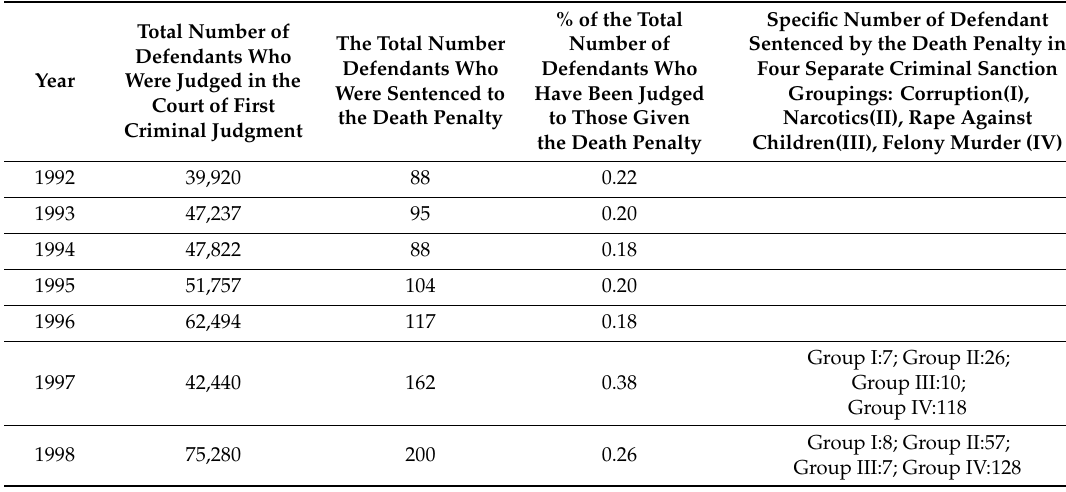
Table 3. Death penalty application in Vietnam during 1992–2002. (Source: the Supreme People Court of Vietnam cited in